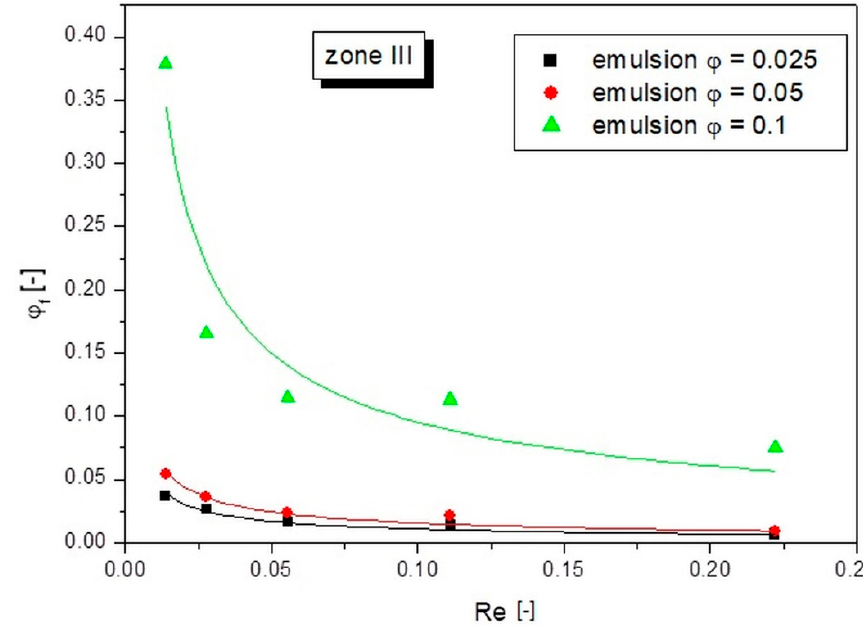
Figure 9. Dependences of the actual concentration on the Re number of the liquid for different emulsion concentrations in zone III.